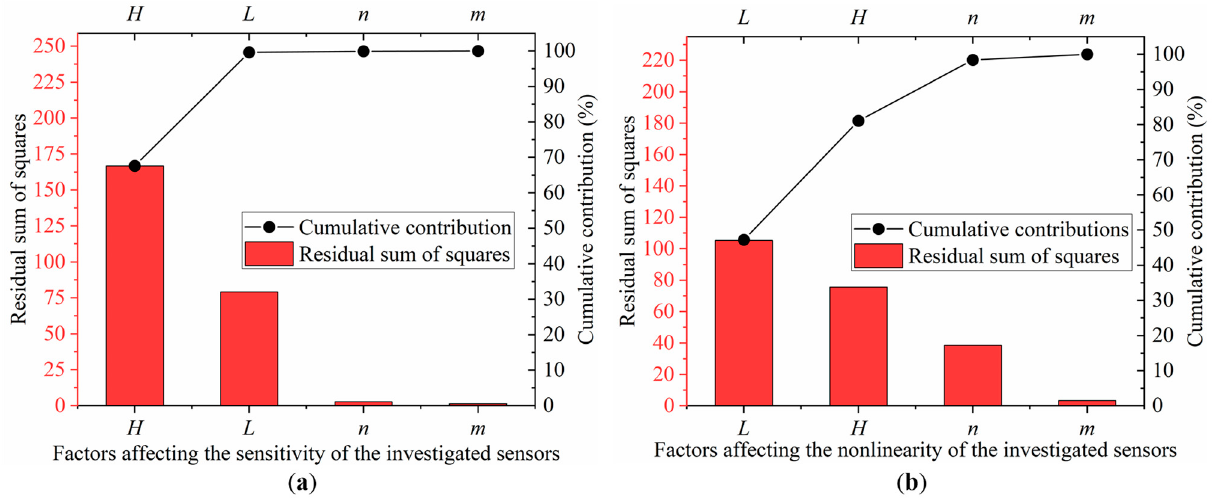
Figure 9. ( a ) The Pareto ANOVA diagram for sensitivity; and ( b ) the Pareto ANOVA diagram for nonlinearity. for